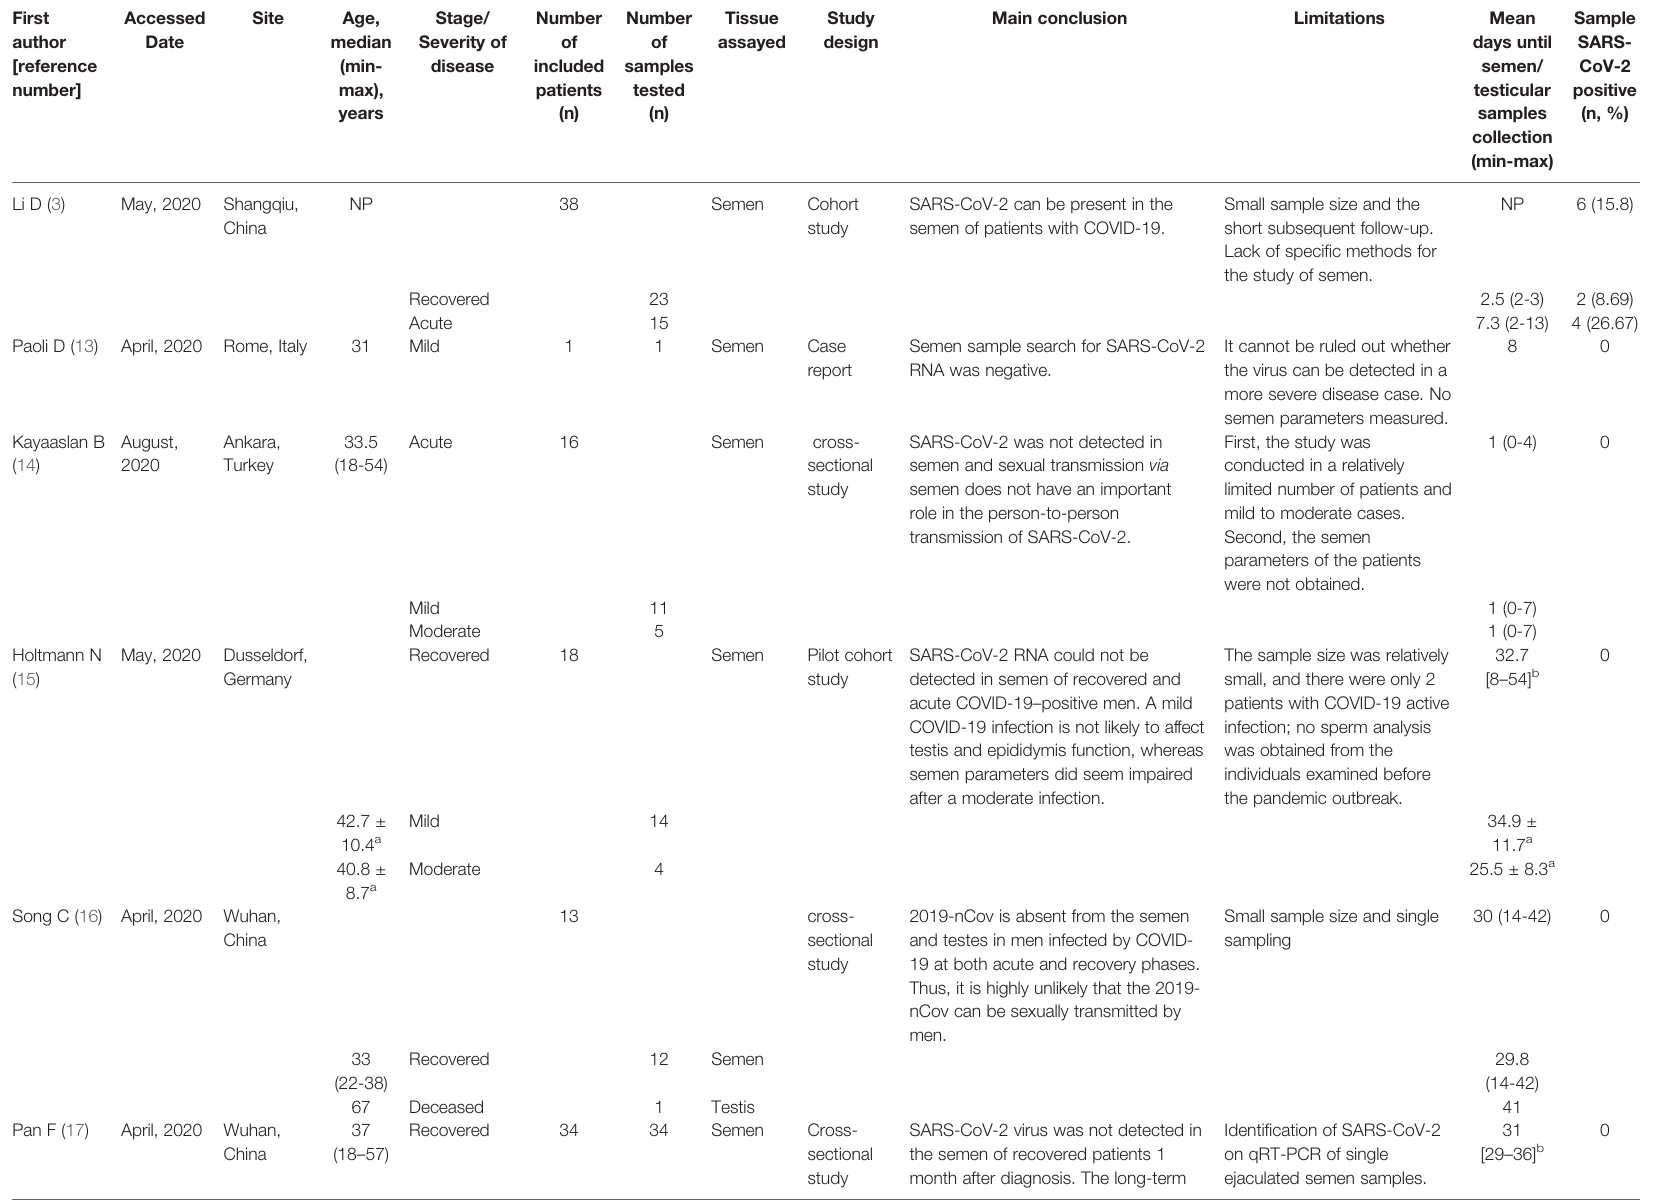
TABLE 1 | Characteristics of included